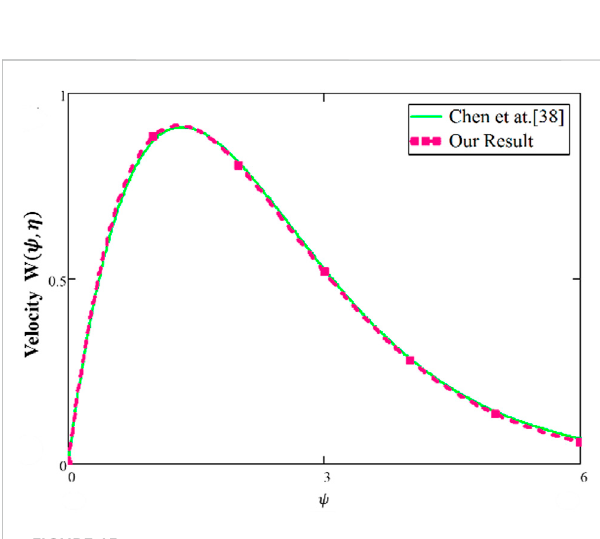
FIGURE 15 Comparison of our results with the results by Chen et al. (2022) for validation.